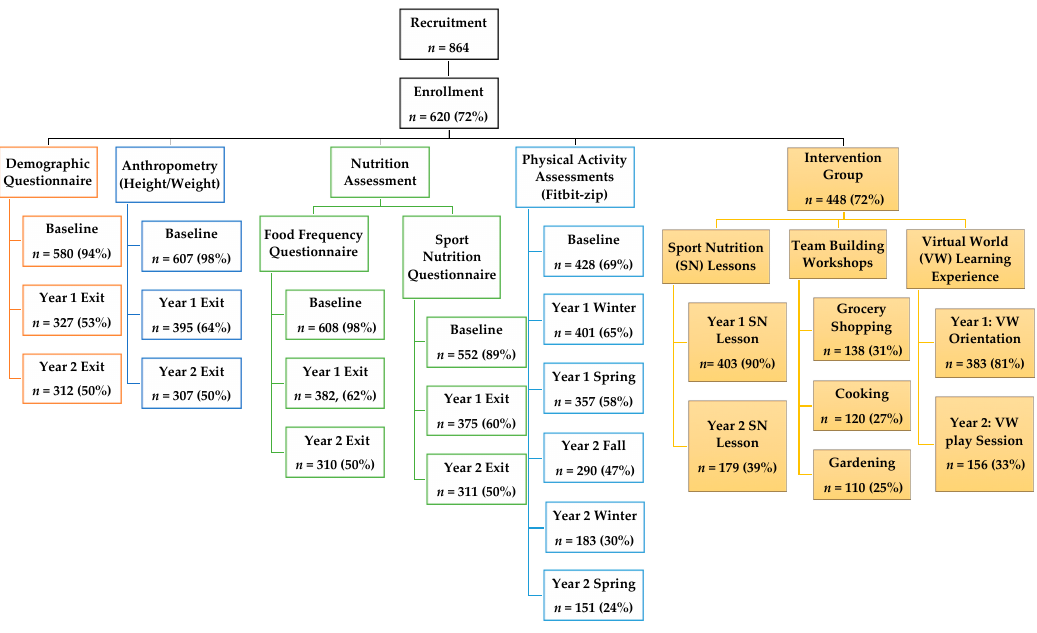
Figure 1. WAVE program youth participant attendance and retention by intervention activities. SN: sports nutrition; VW: virtual world.